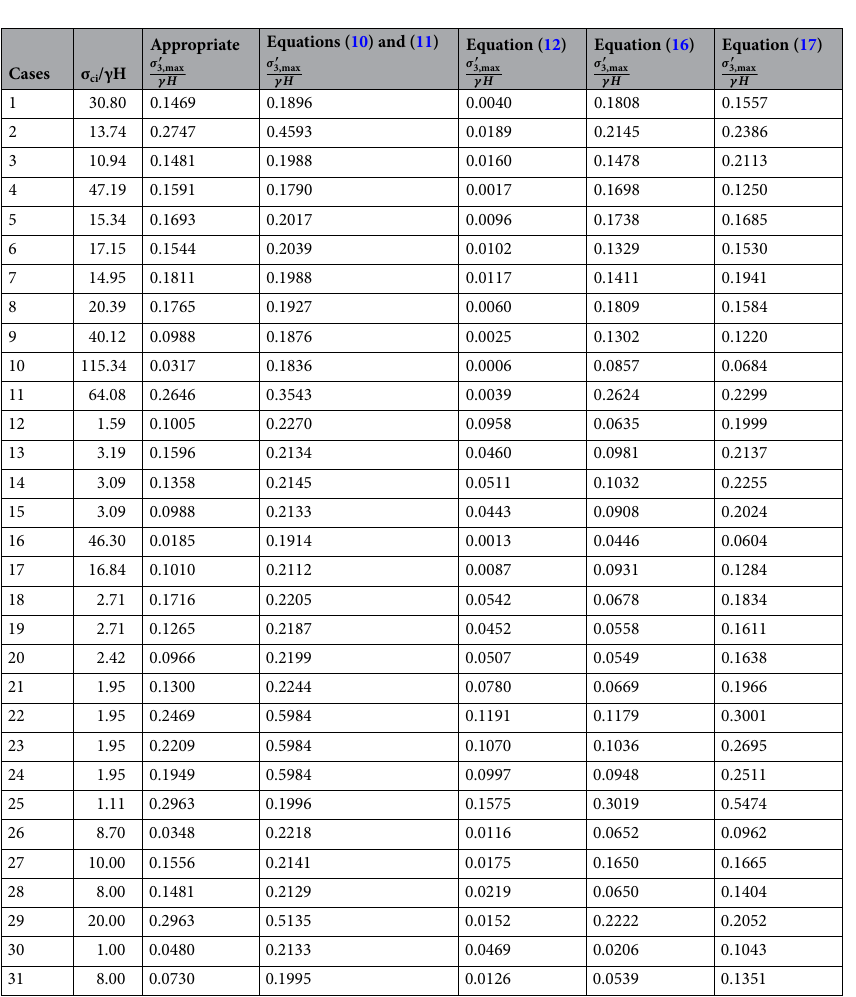
Table 4. Calculation